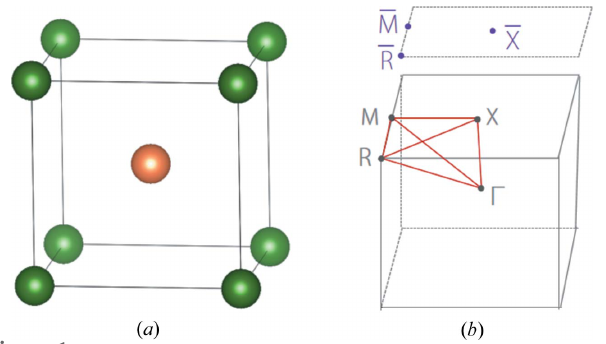
Figure 1 ( a ) CsCl-type crystal structure and ( b ) its Brillouin zone of bulk and the (001) surface.